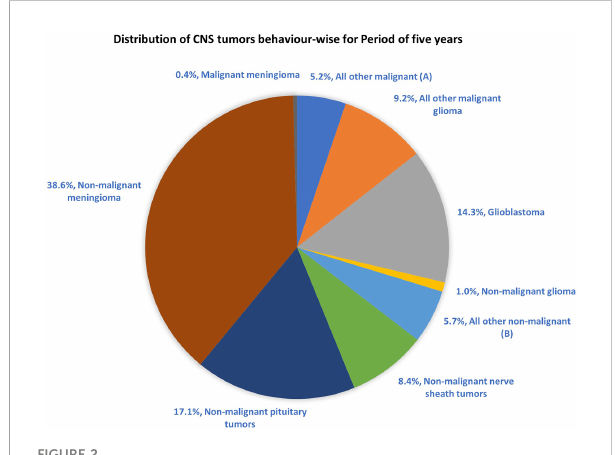
FIGURE 2 Distribution of primary brain and other CNS tumors by behavior (5-